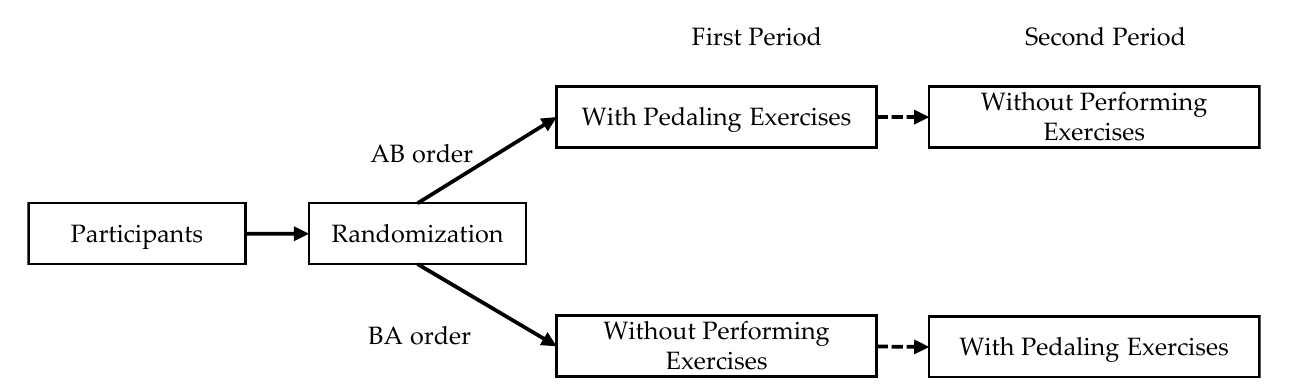
Figure 3. Crossover study design.